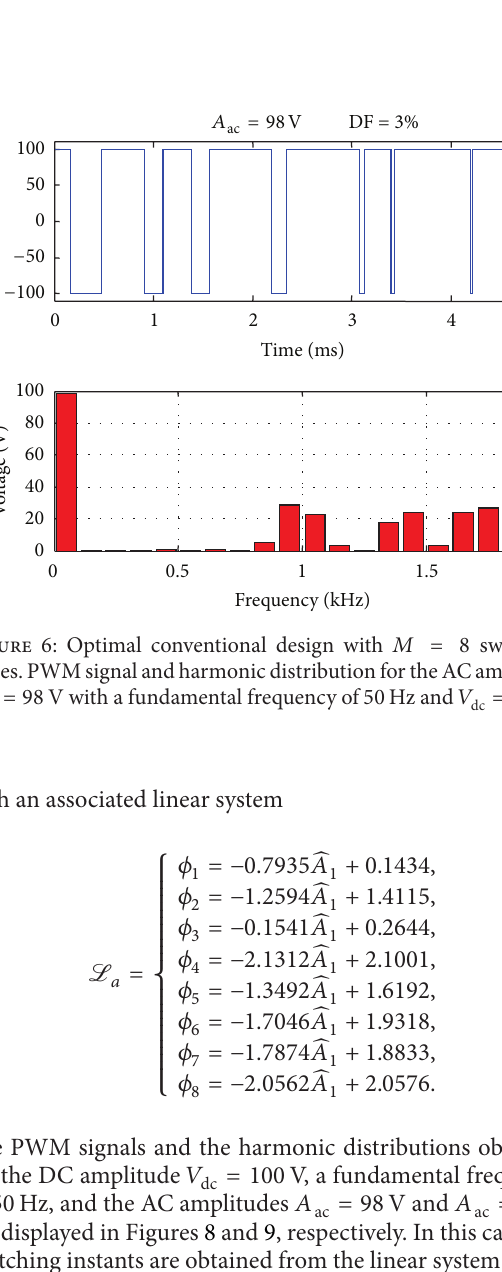
Figure 8: Optimal advanced design with 𝑀 = 8 switching cycles.